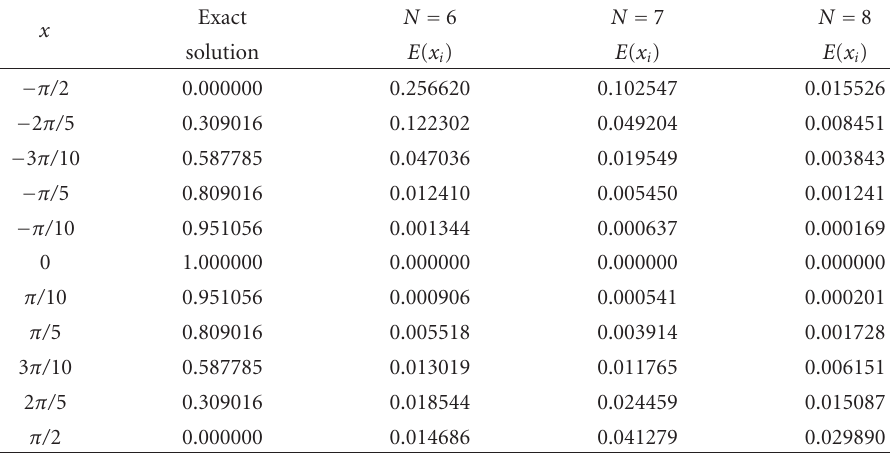
Table 4.1. Error analysis of Example 4.1 for the x